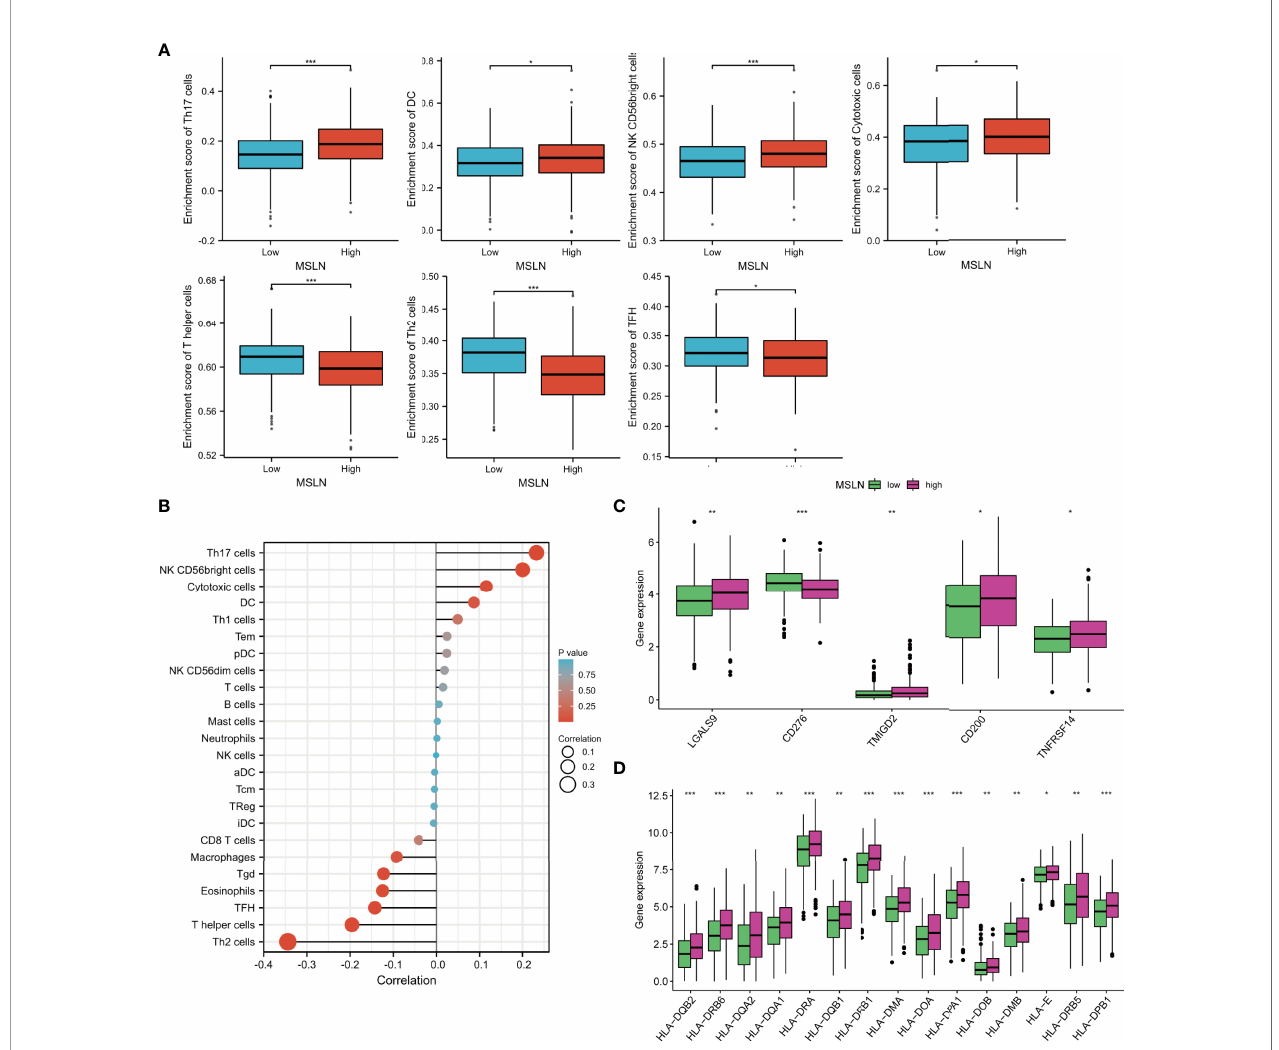
FIGURE 7 | Correlation of MSLN with immune cell in fi ltration and immune checkpoint in ovarian cancer. (A) Immune cell in fi ltration level in the high MSLN expression group and low MSLN expression group in TCGA cohort. (B) Correlations between MSLN and Immune cell in fi ltration in ovarian cancer is shown in lollipop charts; The larger the circle, the stronger the correlation. (C, D) Expression level of immune checkpoint (C) and HLA molecule (D) in the high MSLN expression group and low MSLN expression group in TCGA cohort. *, p < 0.05; **, p <0.01; ***, p